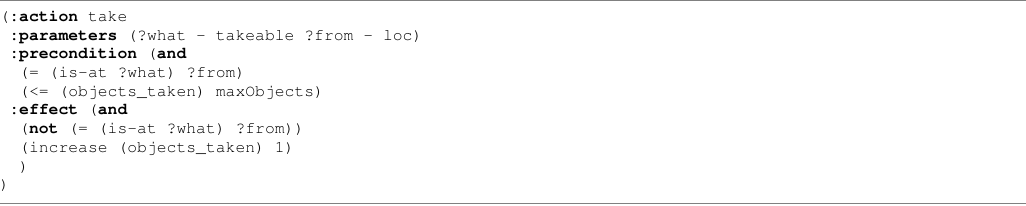
Figure 2. Extract of the action scheme for the take action encodes preconditions and effects in PDDL.